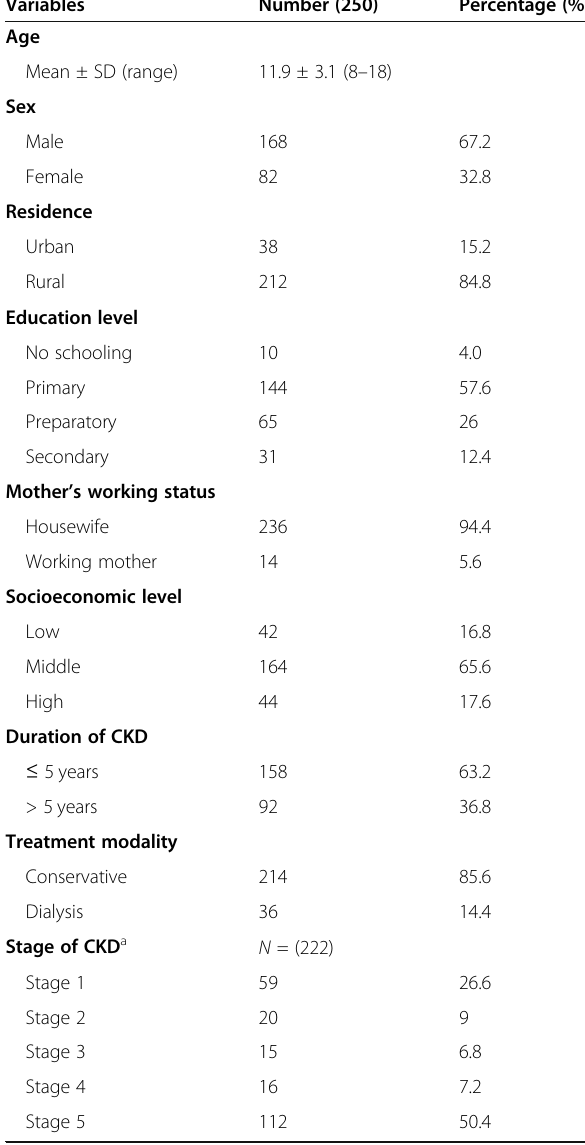
Table 1 Sociodemographic and clinical characteristics of children with CKD, Assiut, Upper Egypt, 2018